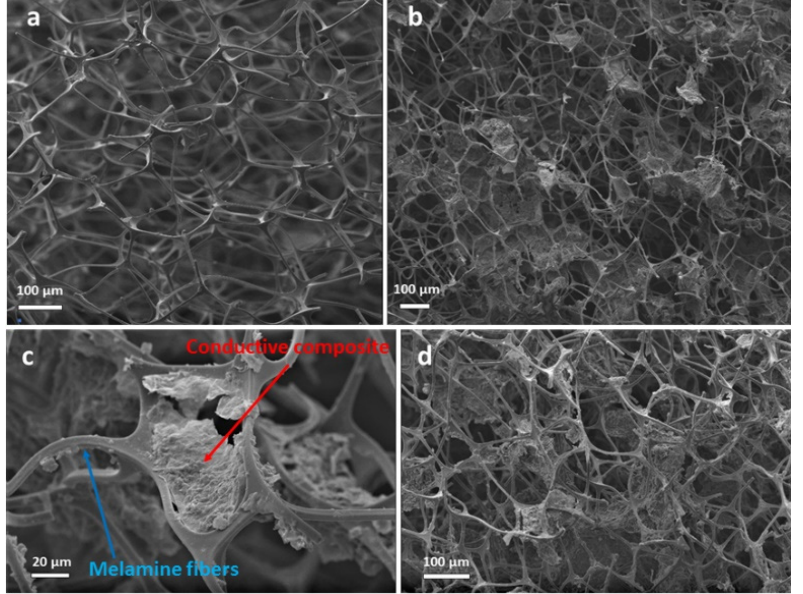
Figure 2. SEM images of the tomographies of ( a ) pure MS sample; ( b – d ) MS sample impregnated with the G/MWNT- f -OH/cellulose with the G/MWNT- f -OH/cellulose nanocomposite.